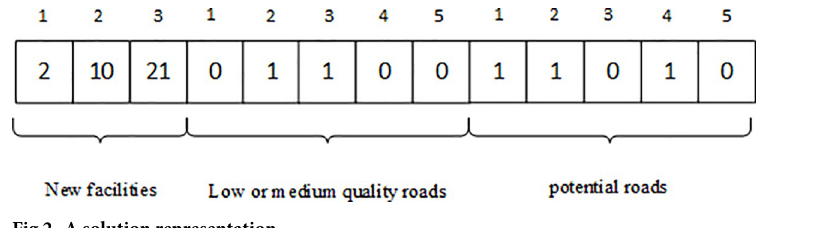
Fig 2. A solution